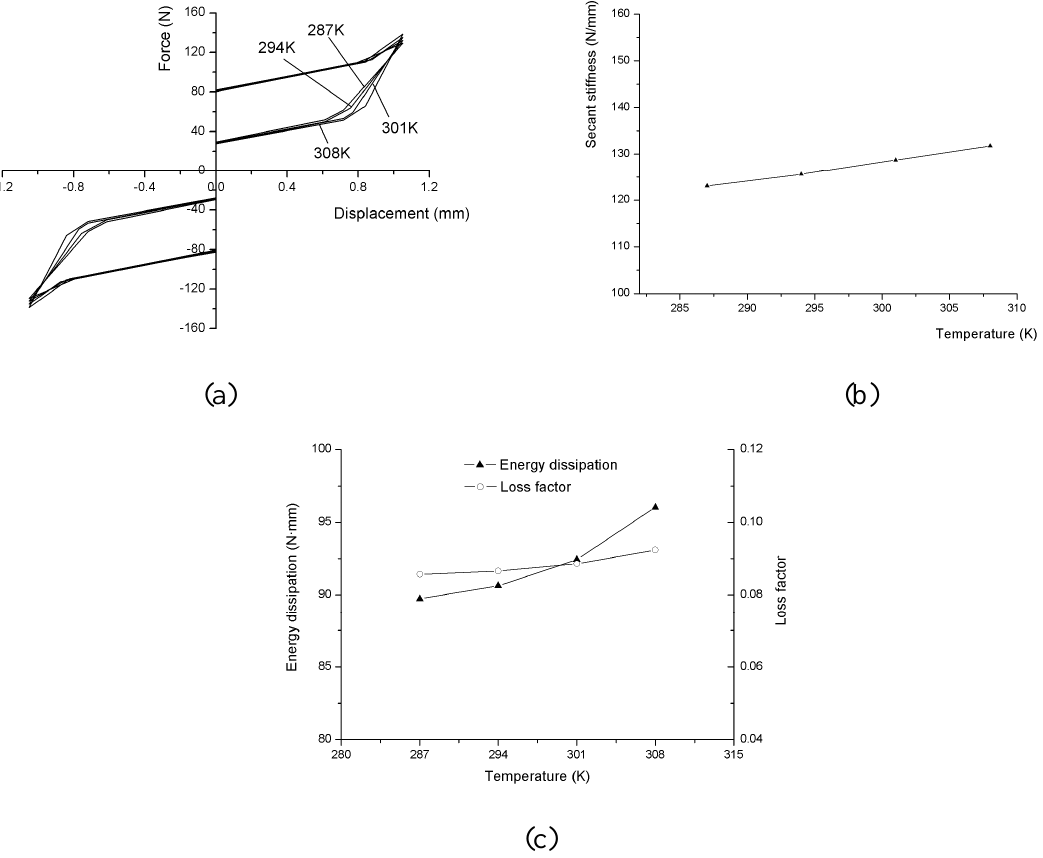
Figure 12 . Mechanical behavior of damper with temperature variation: (a) Schematic diagram of the force-displacement curve; (b) Secant stiffness; (c) Dissipated energy and loss